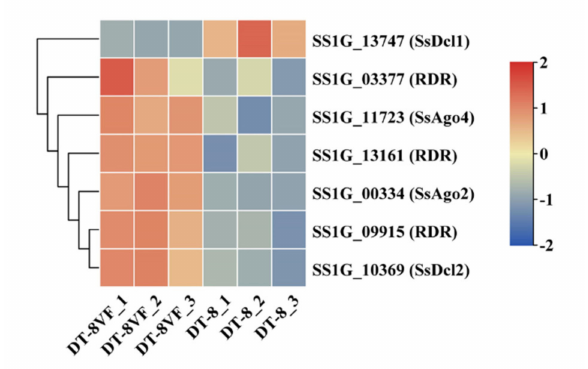
Figure 5. The expression profiles of antiviral RNA silencing